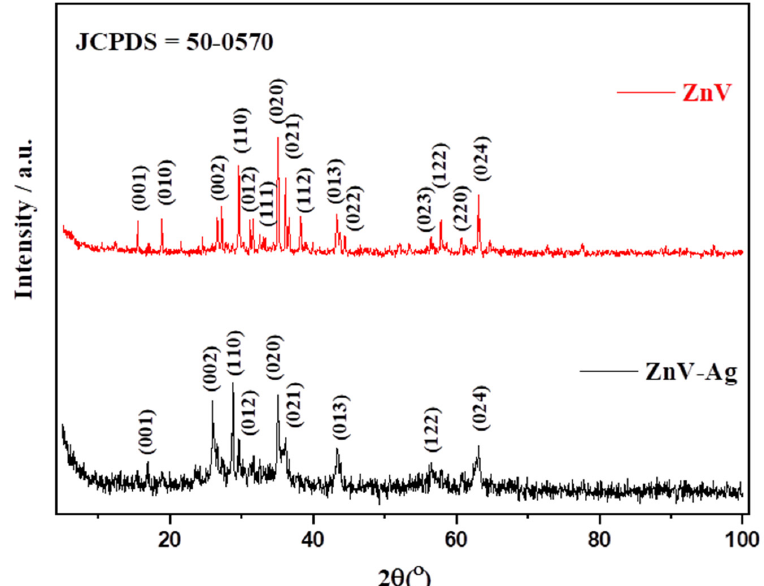
Figure 1. XRD data of ZnV and ZnV ‐ Ag NC.